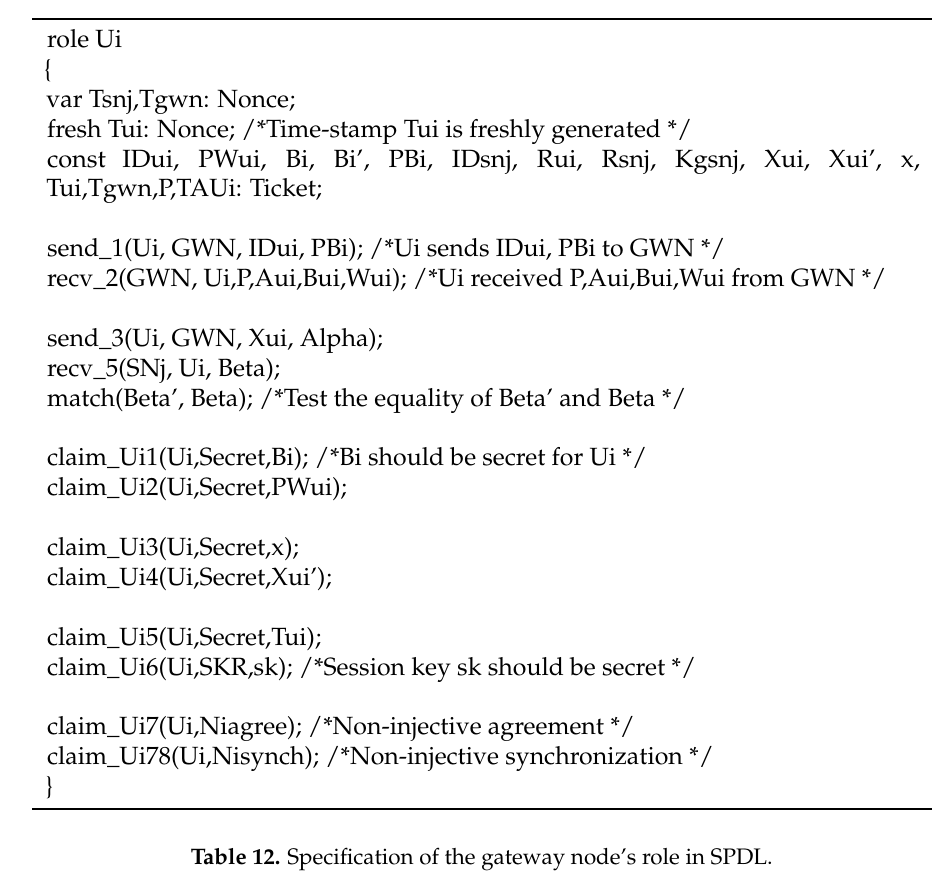
Table 11. Specification of the user’s role in SPDL.